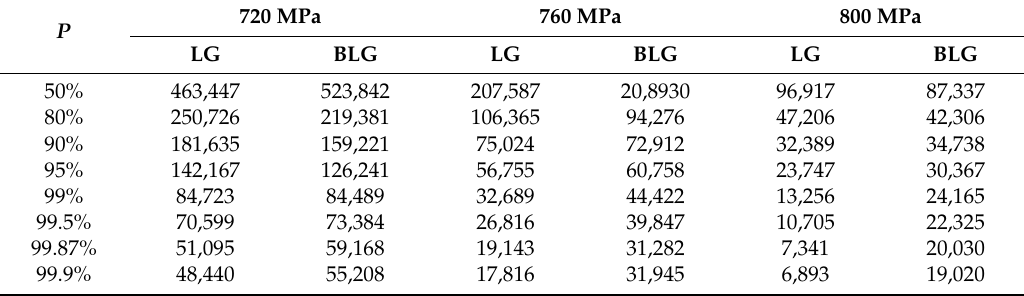
Table 6. Fatigue life calculated from P-S-N curves under specific reliabilities (cycles).